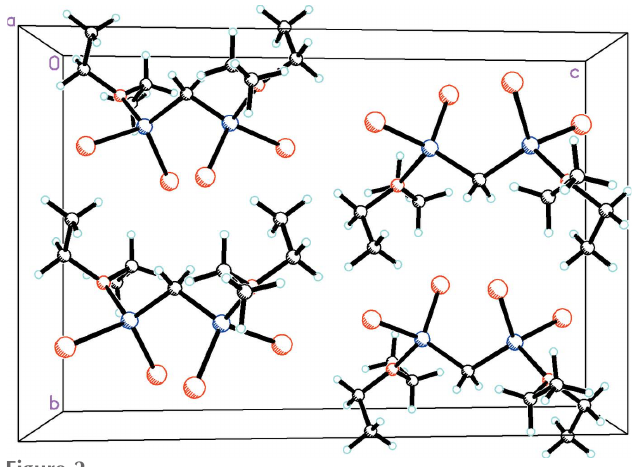
Figure 2 Packing diagram of 1 viewed from the [010] direction.